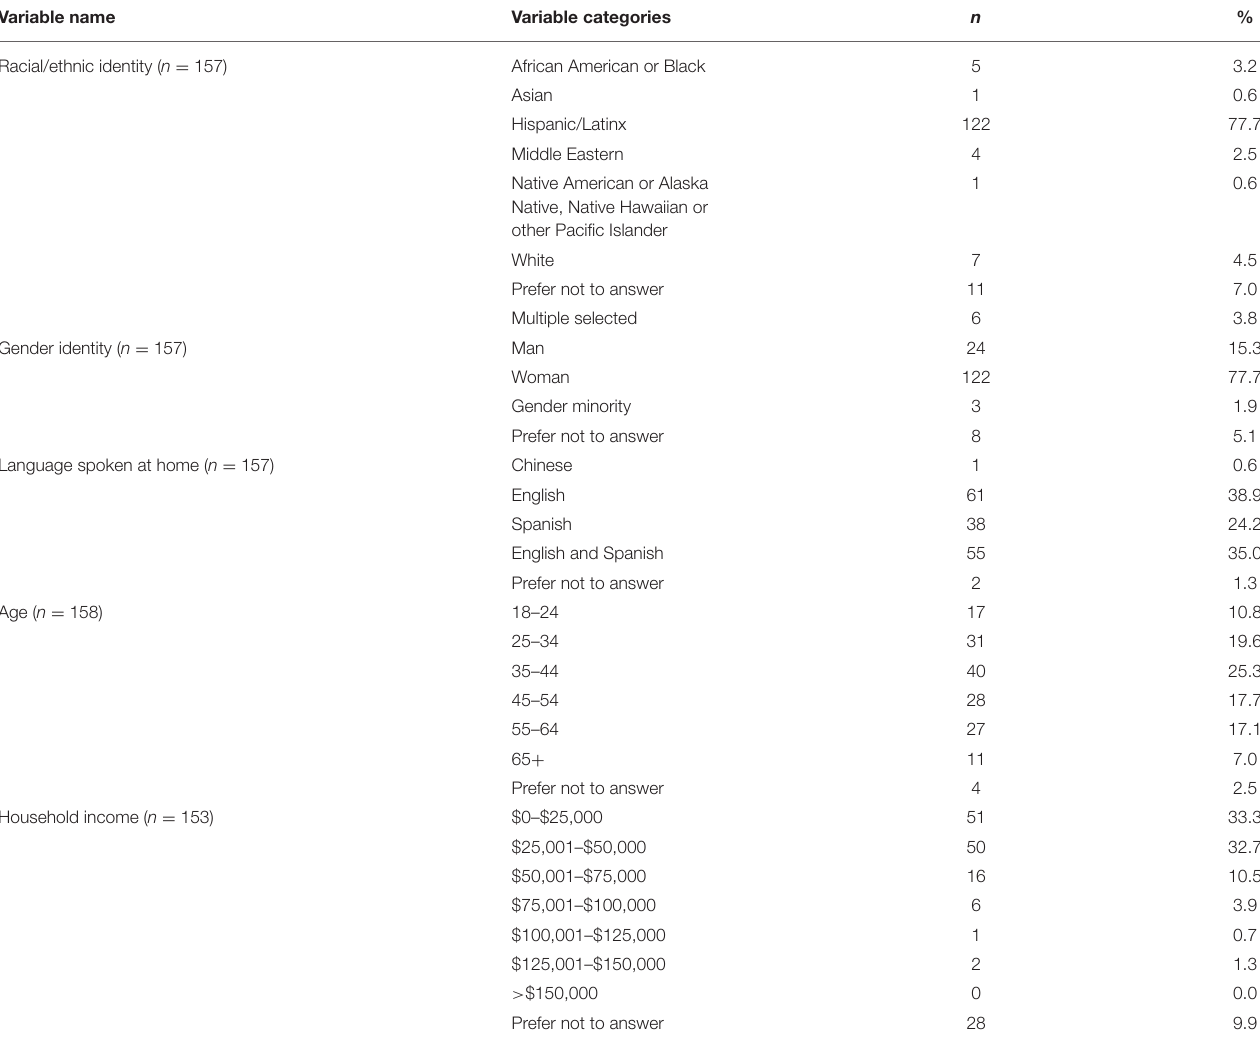
TABLE 1 | Demographic information of